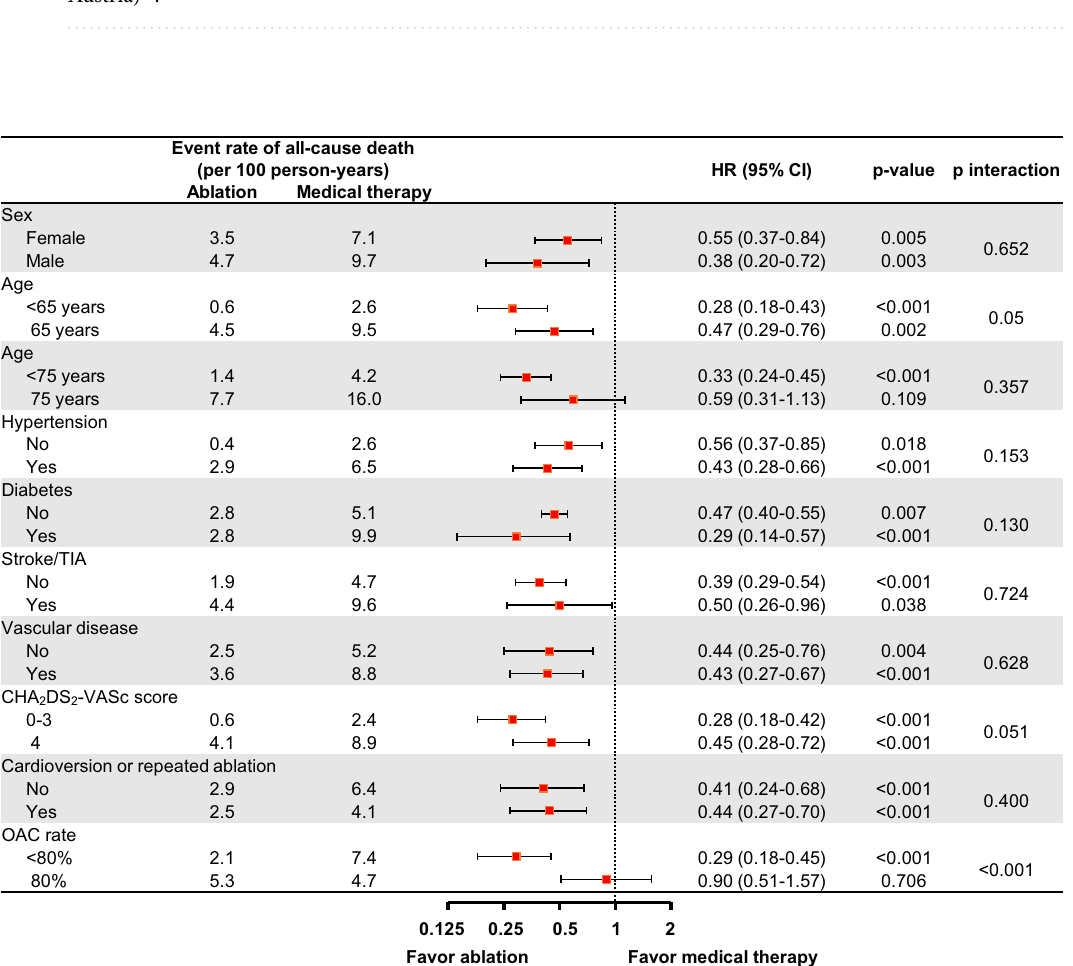
Figure 2. Weighted cumulative incidence curves of ( A ) all-cause death and ( B ) cardiovascular death for ablated and medical therapy patients. Figure prepared in R software (version 3.6.1, R Core Team, 2019, Vienna, Austria) 22 .